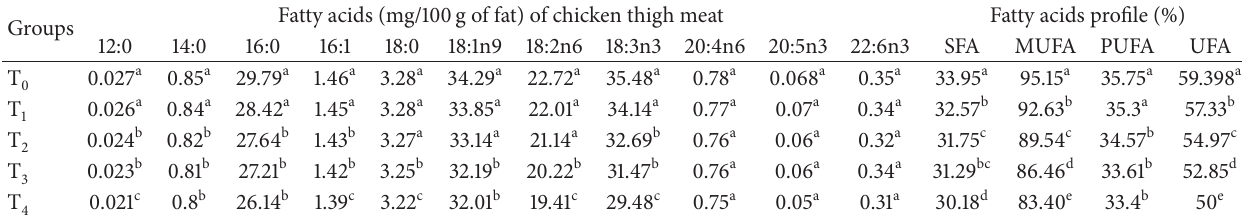
Table 5: Fatty acids profile (mg/100g of fat) of chicken thigh meat.